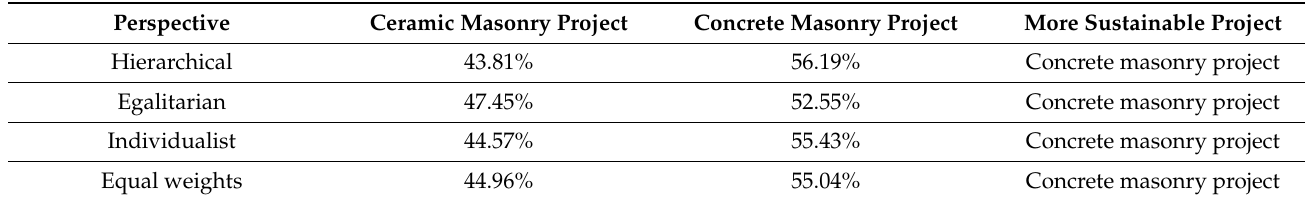
Table 17. Summary table of sustainability